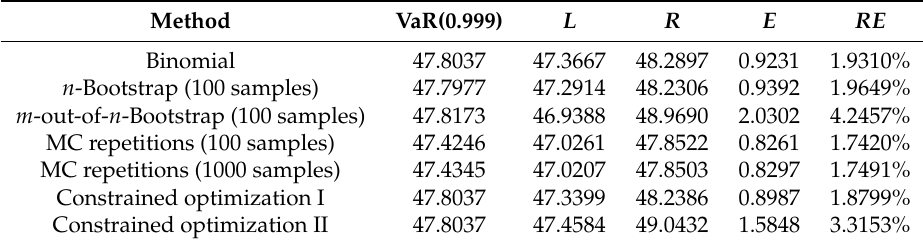
Table 1. Estimated Monte Carlo errors (values in millions of